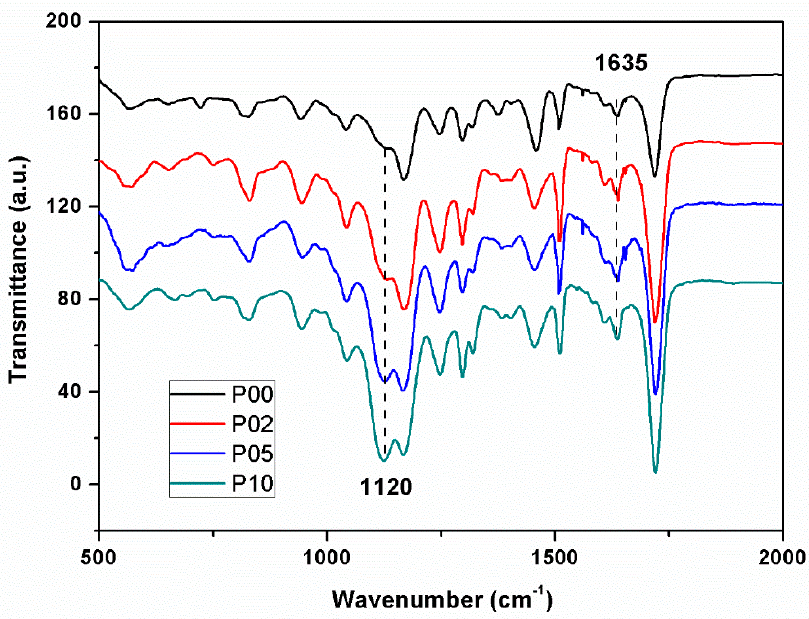
Figure 2. FTIR spectra of composite resins with different POSS additions.